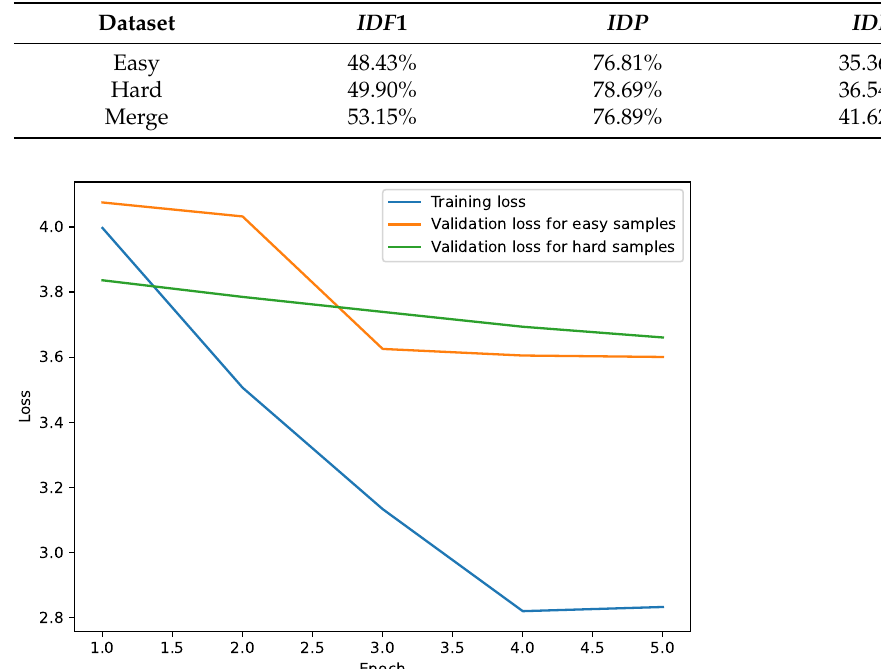
Table 5. The results of the data sampling method.